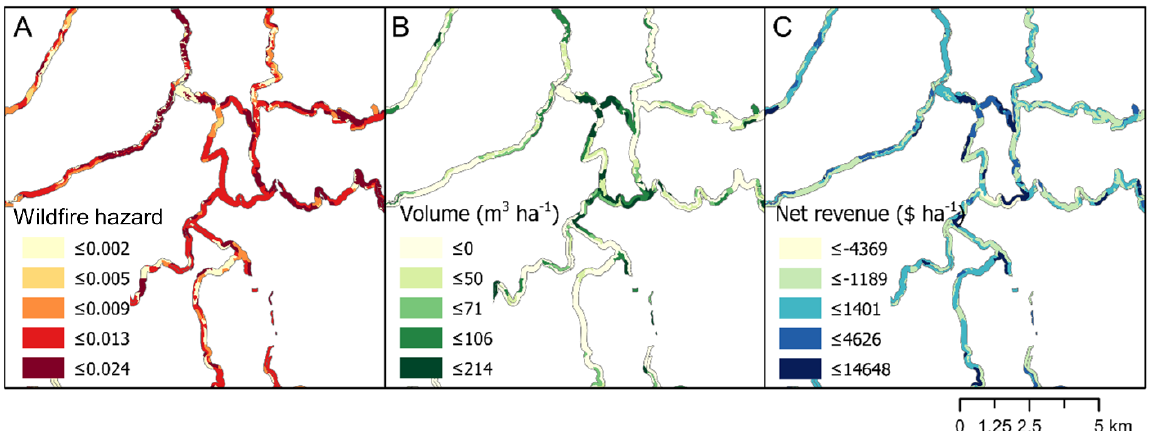
Figure 2. Distribution of priority objective values for the individual fuel break segments for a sample of the northeastern portion of the study area: ( A ) wildfire hazard, computed as the product of the conditional probability of flame length > 1.25 m and annual burn probability, derived from FSim outputs [18], ( B ) merchantable volume, and ( C ) net revenue. The geographical location of these segments is shown in the red box in Figure 1.